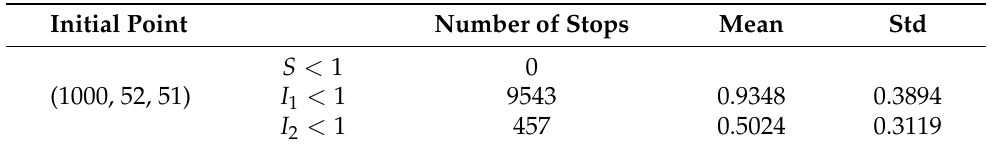
Table 5. Example 3: Euler–Maruyama